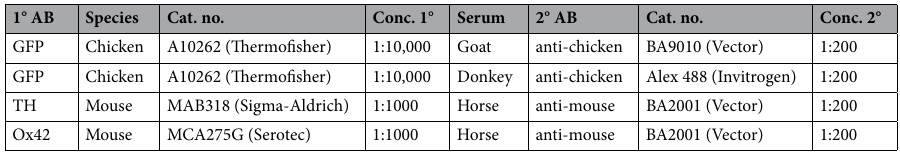
Table 1. Antibodies used in the current study for immunohistochemical